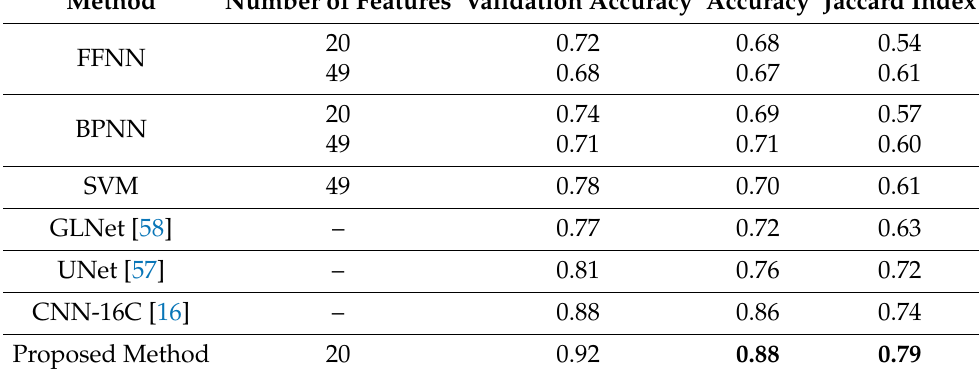
Table 5. Performance comparison of the proposed method using the natural dataset from the Antczak’s image database.